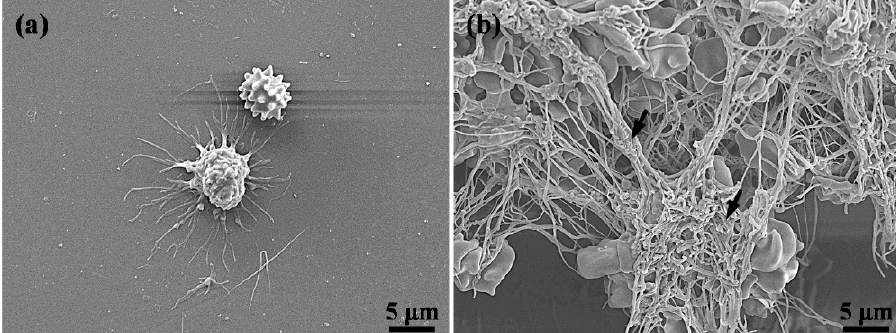
Figure 6. The FE-SEM images of RBC morphology on the ( a ) untreated Ti implant and ( b ) IDCT- Ti/GRGD-1